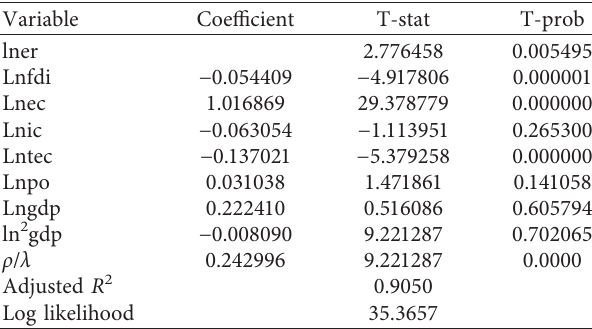
Table 4: Estimated results of direct effects.